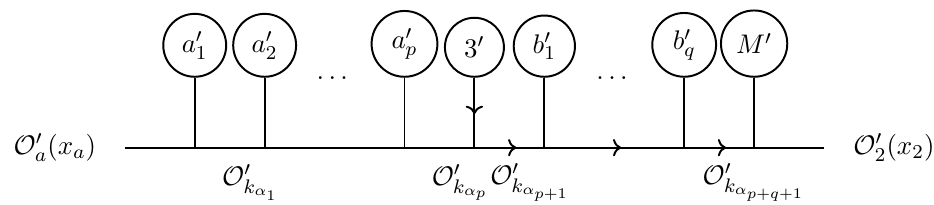
Figure 15 . The ( M − 1) -point conformal blocks where we expand the circle filled with 3 0 in figure 10. Here the arrow means that x 3